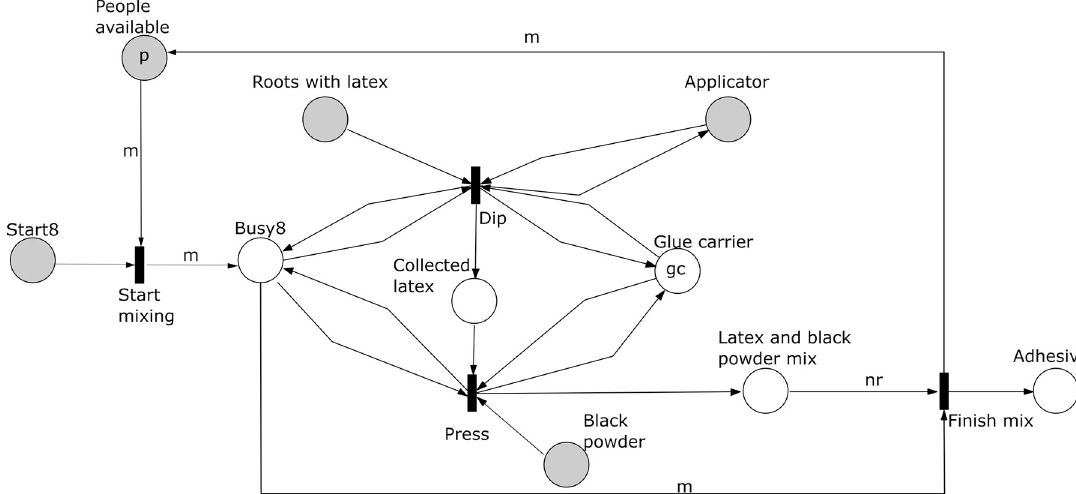
Fig 19. Subprocess 8 Dip and Mix of the O . Schinzii